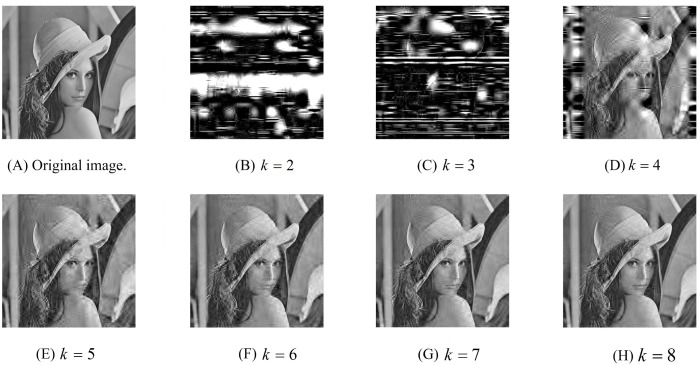
Original secret image and the reconstructed images with different threshold value k.(B)PSNR = 3.0434dB; (C)PSNR = 2.4072dB; (D)PSNR = 11.786dB; (E)PSNR = 24.1027dB; (F)PSNR = 25.6763dB; (G)PSNR = 26.8478dB; (H)PSNR = 27.9183dB.